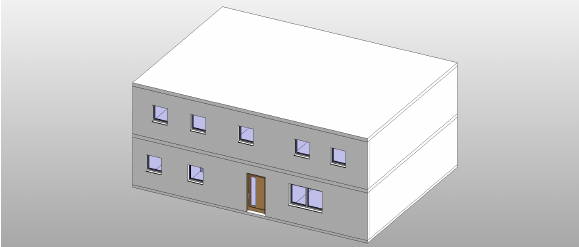
Figure 1. Island scenario input: An OSM polygon, ©OpenStreetMap contributors 3 .